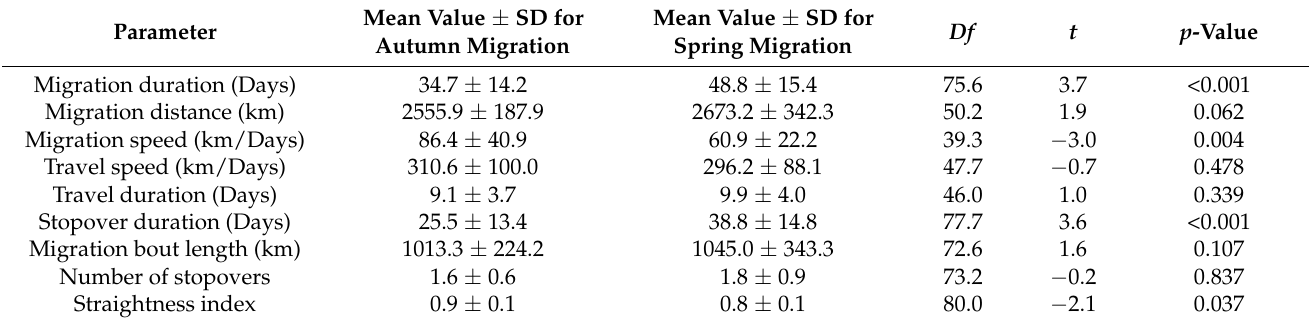
Table 2. Statistical comparison of the key spring and autumn migration parameters of white-naped cranes Antigone vipio (n = 39) based on Student t -tests with unequal variances (within an Excel environment).